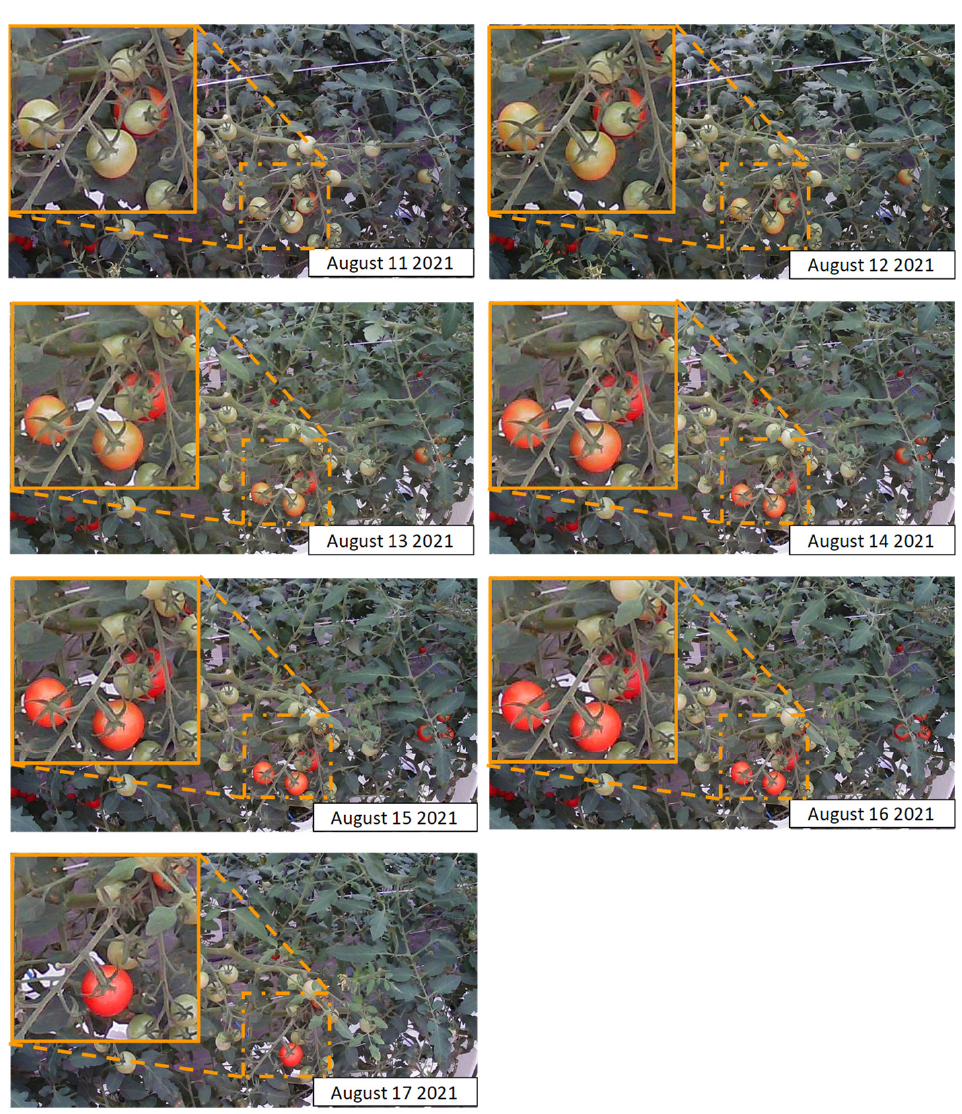
Figure 5. Images taken using a fixed-point camera.